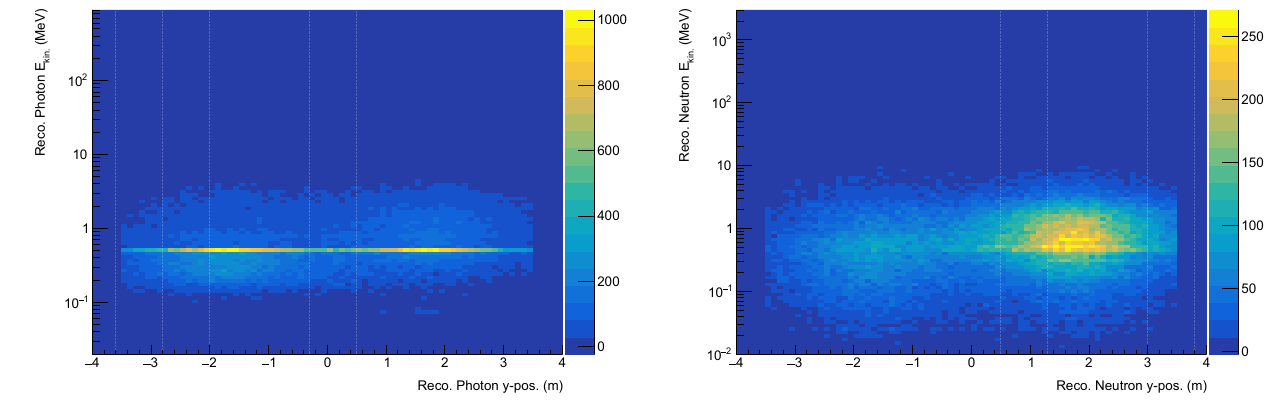
Figure 6. The distribution of the kinetic energy E kin . as a function of the y -position of the reconstructed photons ( left column ) and neutrons ( right column ) in the upper detector plane. The materials analyzed are Magnesium and Cesium ( upper row ), Chromium and Ytterbium ( middle row ), as well as Molybdenum and Lead ( bottom row ). The hits from the empty container are subtracted.